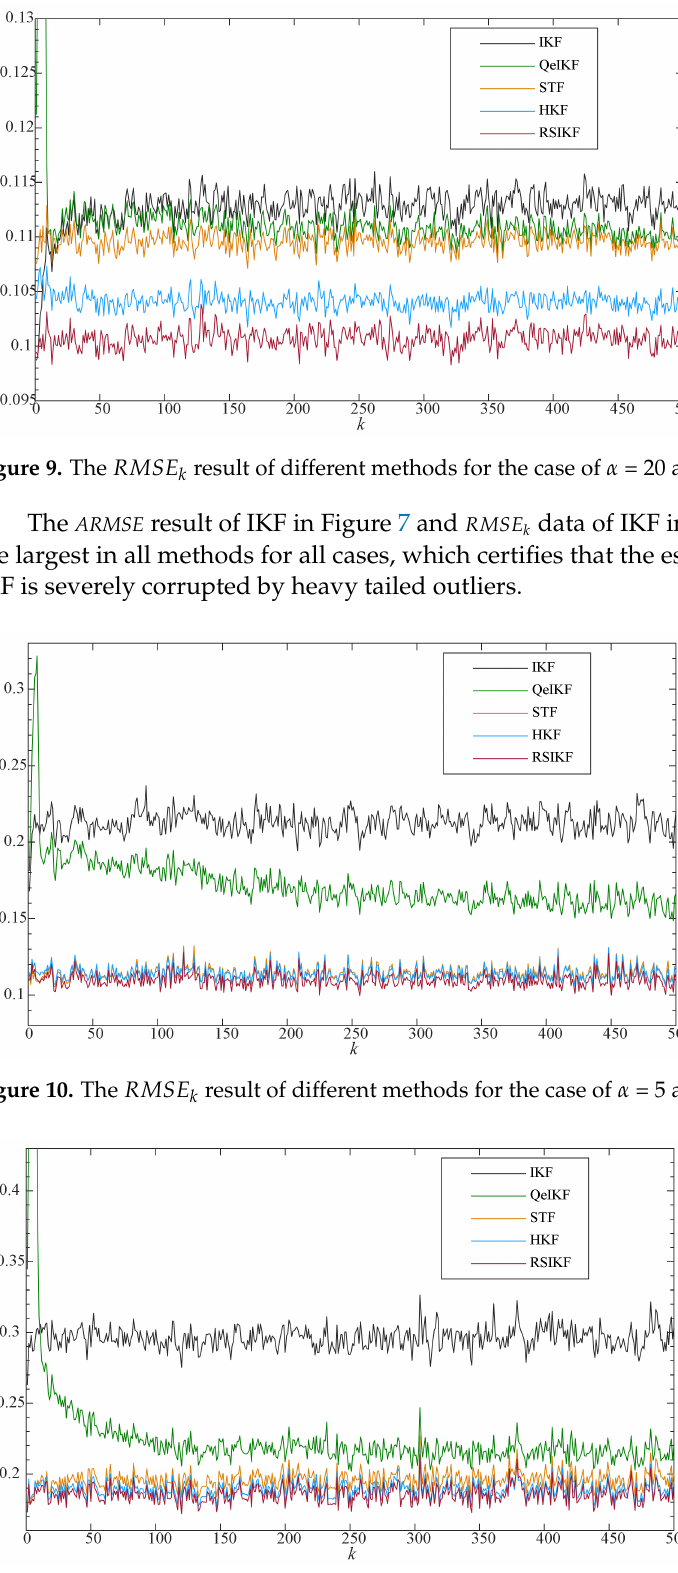
Figure 11. The RMSE k result of different methods for the case of α = 5 and β =